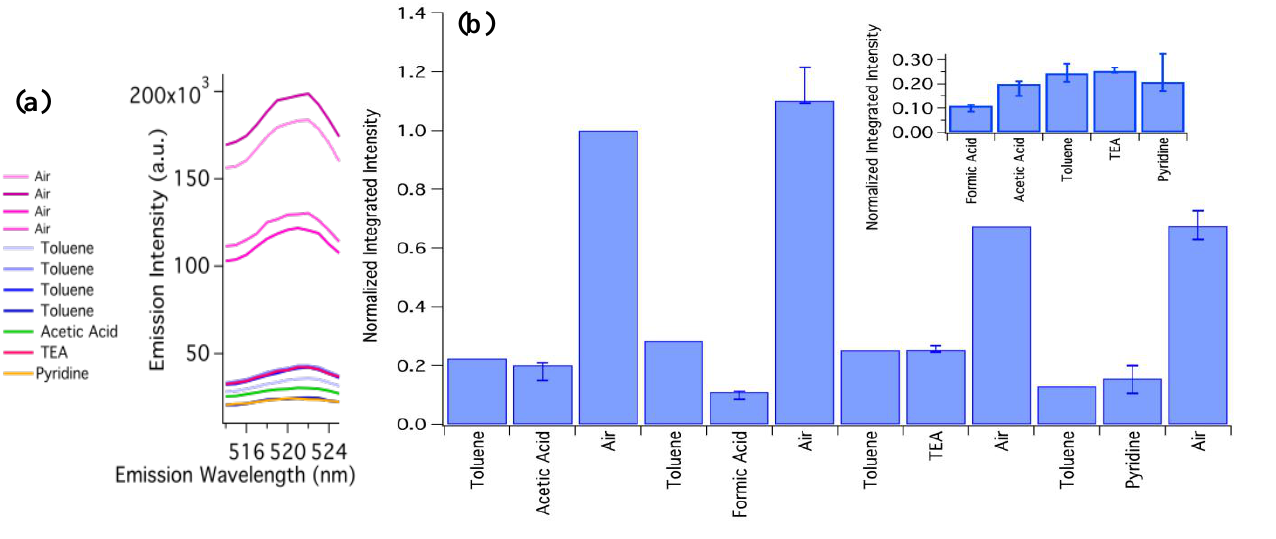
Table 1. Results of the T-test for H